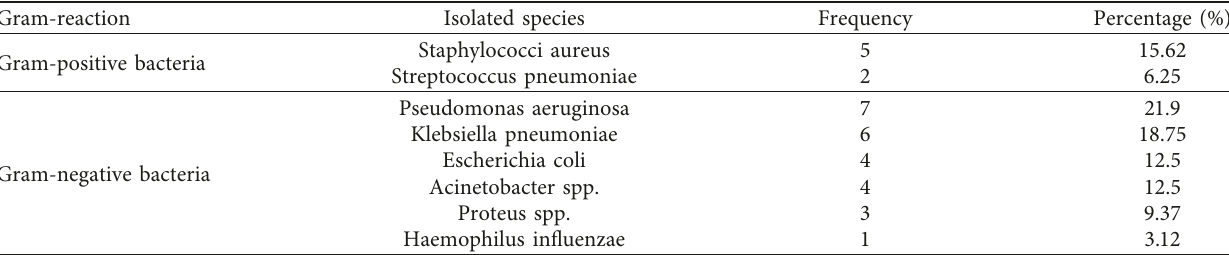
Table 3: Sputum bacteriology from acute exacerbation of chronic obstructive pulmonary disease patients at JUMC, southwest Ethiopia,